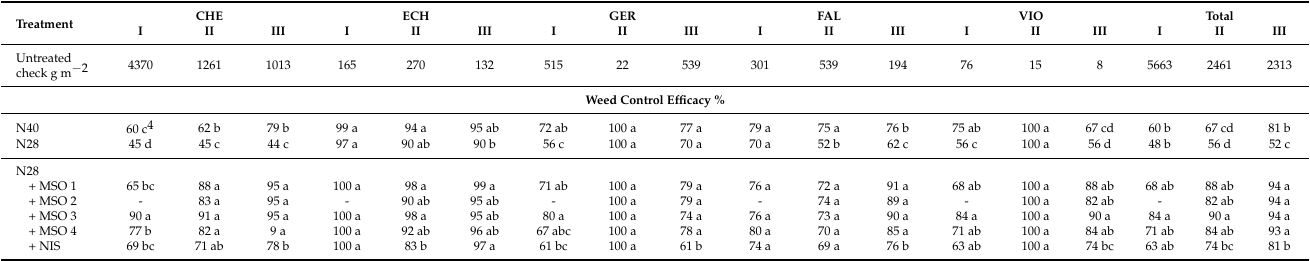
Table 2. Impact of adjuvants on WCE in 2017–2019.